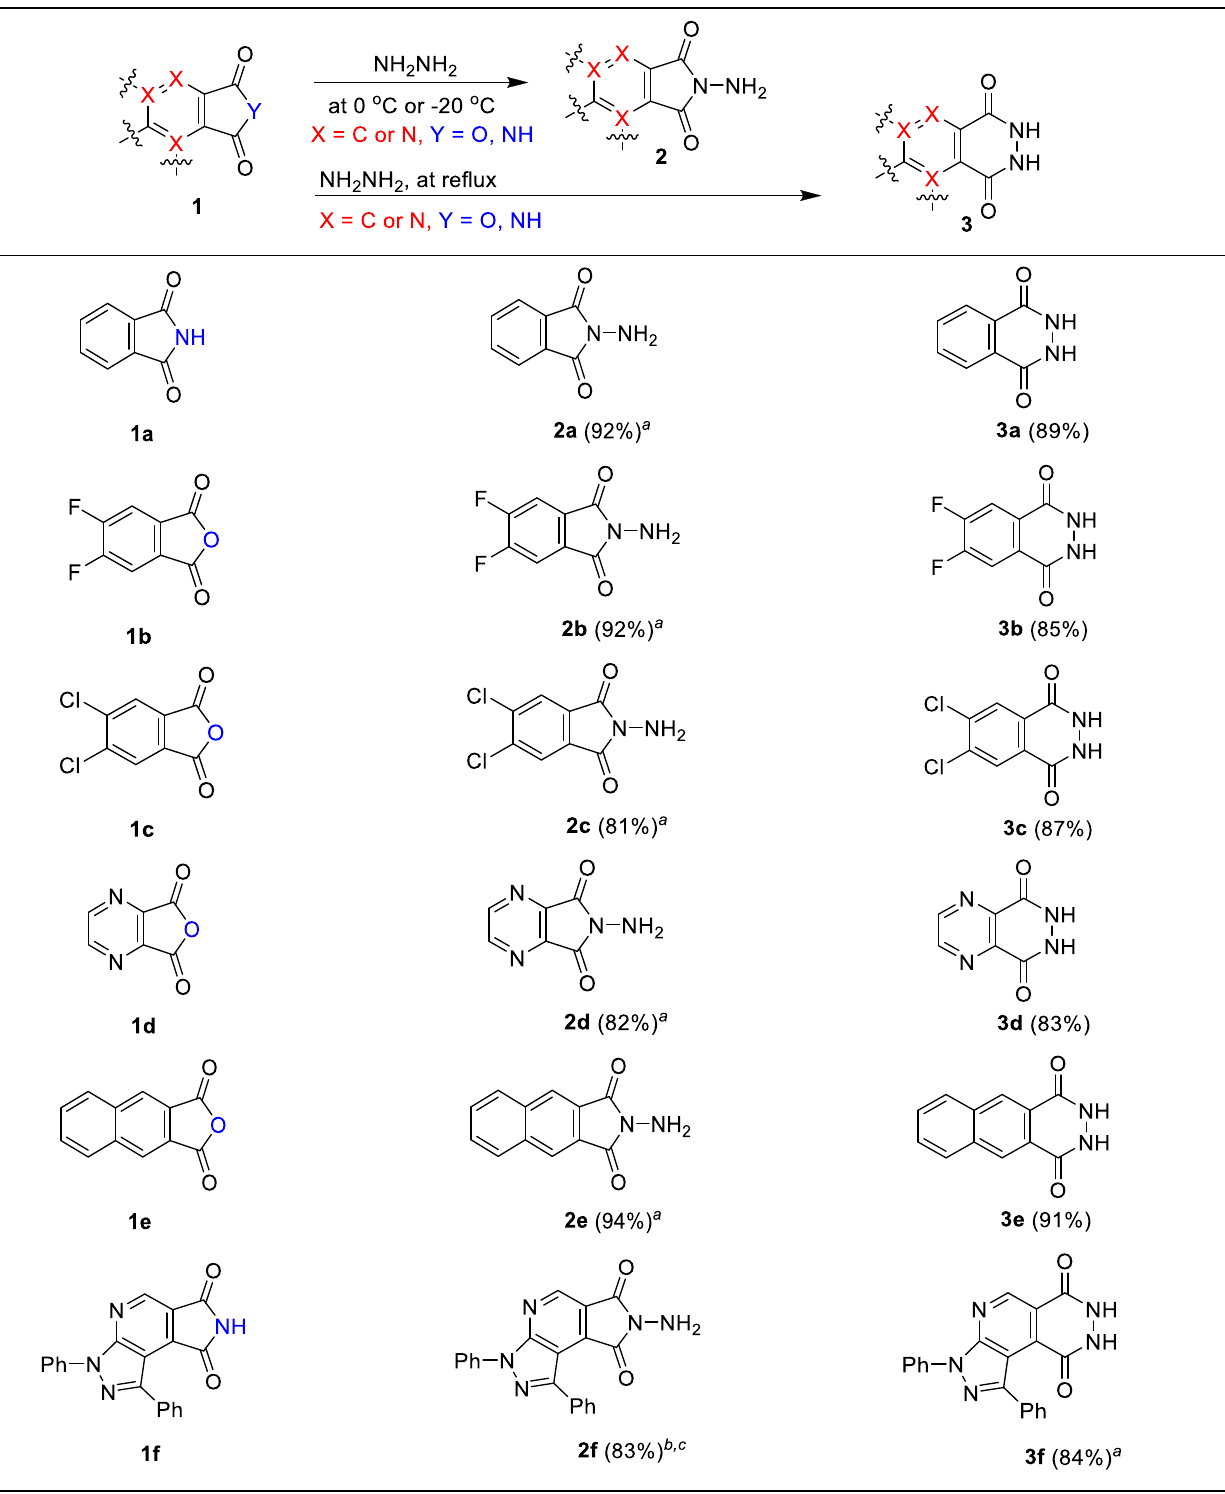
Table 1. The thermodynamic-kinetic control synthesis of N -aminophthalimides 2a – f and phthalazine 1,4-diones 3a – f .